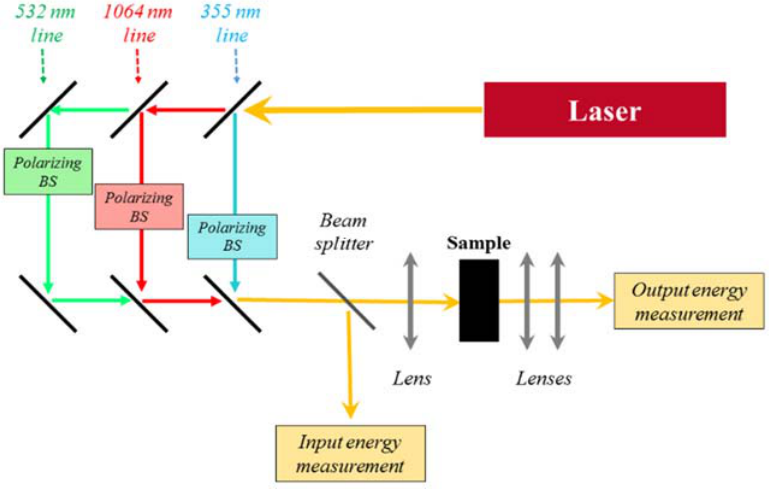
Figure 1. Experimental setup for optical limiting experiments.